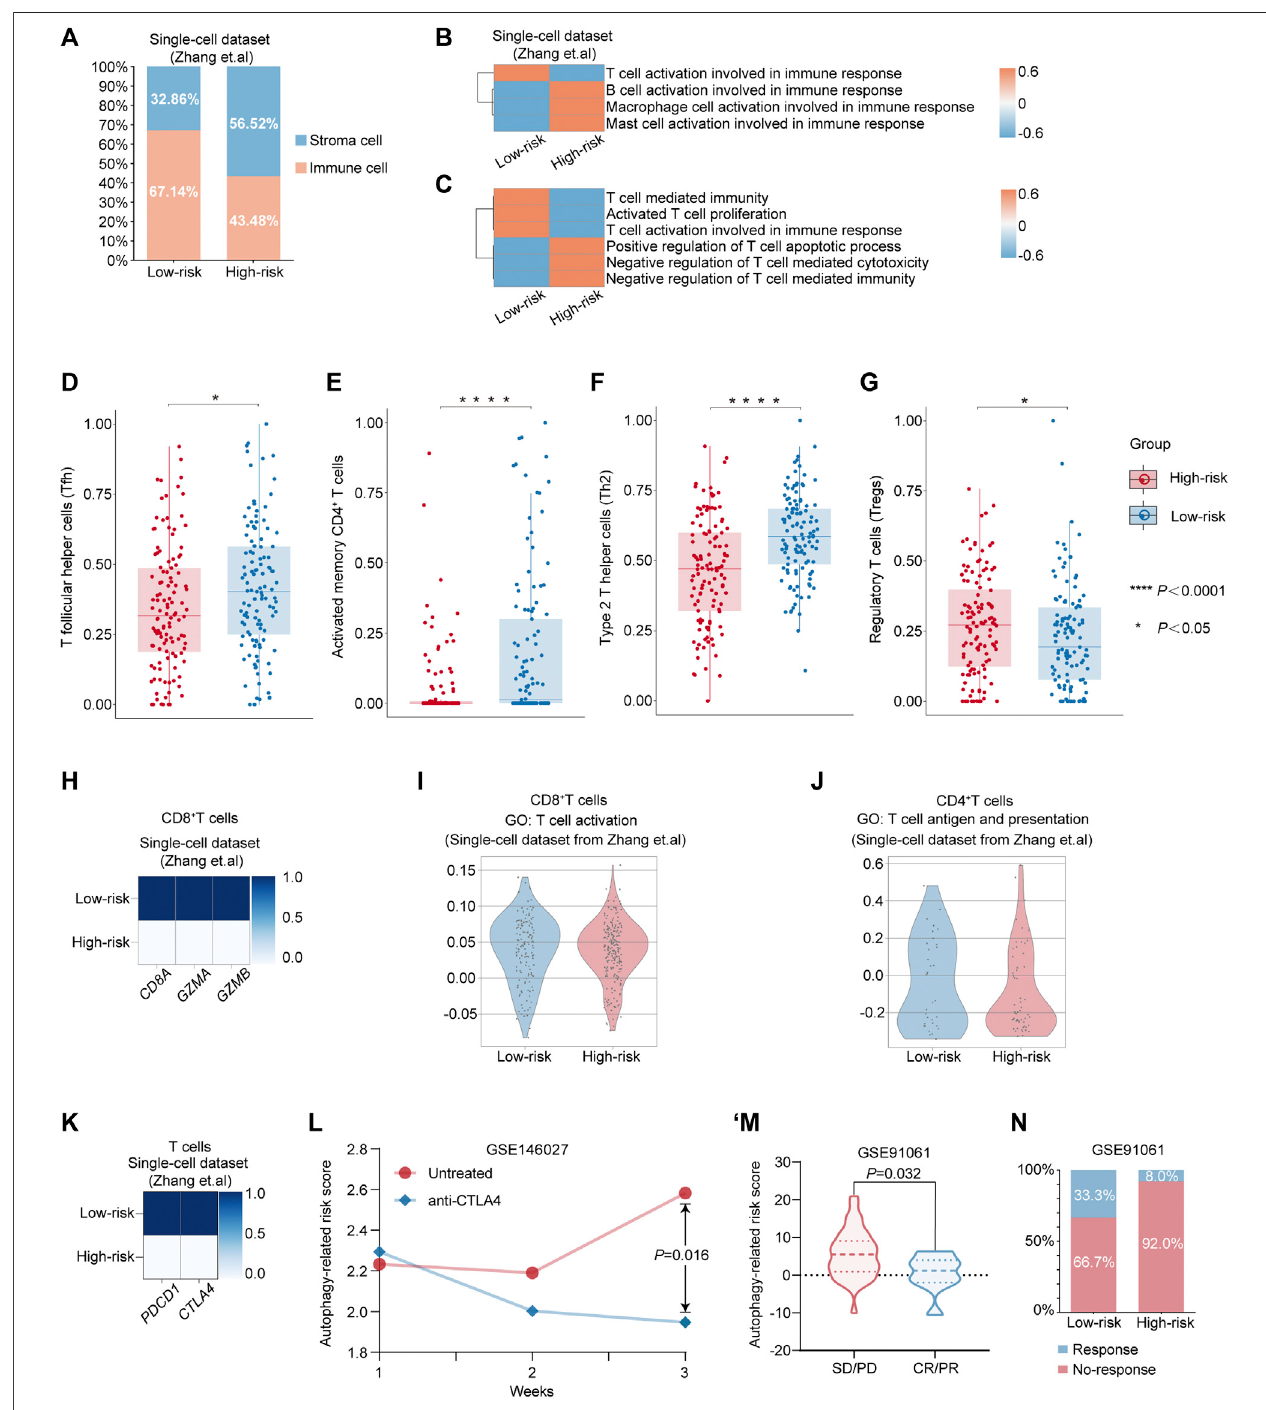
FIGURE4| AlterationsinthefeatureofTcellbetweendifferentrisk-groupspredictedbyautophagy-relatedriskmodel. (A) Percentagesofimmunecellandstromal cells in different risk groups in TME. (B – C) Heatmap showing the expression-based pathway activities scored per cell between the low-risk group and the high-risk group. (D – G) ThedifferentcompositionsofTfollicularhelpercells(Tfh) (D) ,activatedmemoryCD4 + Tcells (E) ,type2 Thelpercells(Th2) (F) andregulatoryTcells(Tregs) (G) betweenlow-riskpatientsandhigh-riskpatientsfromTCGAdataset. p valuewascalculatedbynonparametricMann – Whitneytest.* p value < 0.05.**** p value < 0.0001. (H) Matrix plot showing the mean expression of CD8A , GZMA , and GZMB between the low-risk group and the high-risk group. (I) Violin plot showing the distribution of activity score of “ T cell activation ” from GO database in CD8 + T cells from the low-risk group and the high-risk group, respectively. (J) Violin plot showing the distribution of the activity score of “ T cell antigen and presentation ” from GO database in CD4 + T cells from the low-risk group and the high-risk group, respectively.